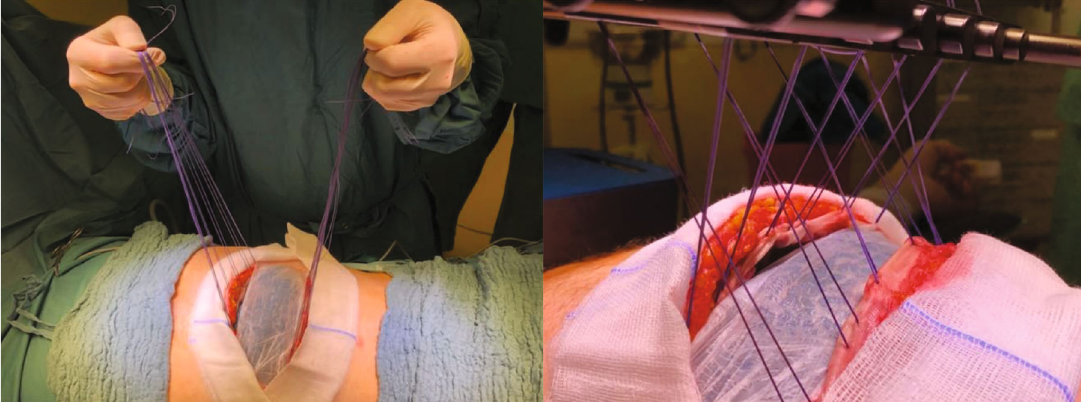
Figure 2: Intraoperative application of Fasciotens Abdomen. Surgical suture (Vicryl USP 1 or 2) was attached to the mesh. The suture was